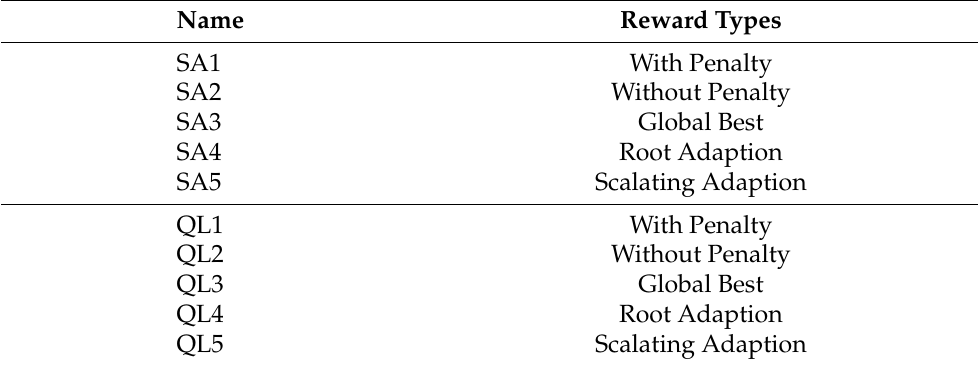
Table 4. SARSA and Q-Learning